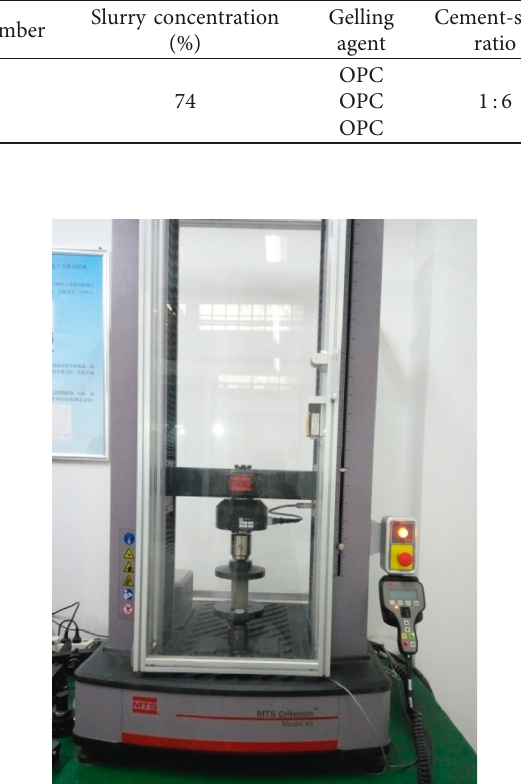
Figure 3: Test platform for measuring the uniaxial compressive strength of the CPB